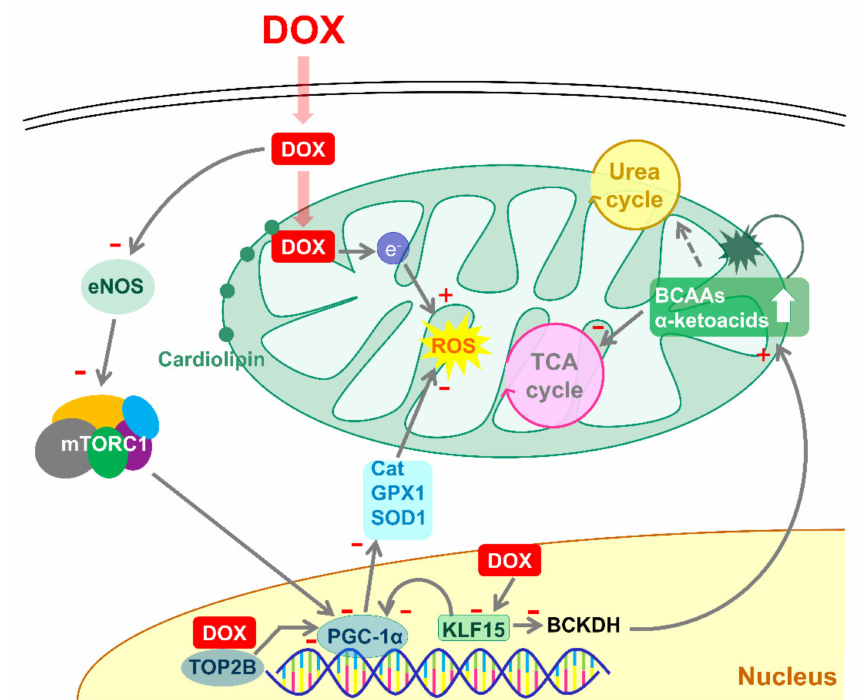
Figure 8. A proposed model of α 5 protective actions on mitochondrial damage induced by doxorubicin (DOX) in cardiomyocytes. Plus ( + ) and minus ( − ) symbol in red colour indicate stimulation or inhibition induced by DOX and, potentially, the α 5 target sites. DOX reduces mitochondrial biogenesis and function, (1) binding to topoisomerase II β (TOP2B), which complexes to the promoters of Ppargc1a and Ppargc1b and blocks transcription of mitochondrial genes, including ROS defense genes, (2) reducing eNOS expression and mTORC1 activity—which are important regulators of mitochondrial physiology, (3) limiting KLF15 gene expression and presumably BCAA oxidation, with α -ketoacid and BCAA accumulation—which are toxic at high levels—beyond reduced TCA cycle intermediates and mitochondrial energy production. Mitochondrial accumulation of DOX is accompanied by increased